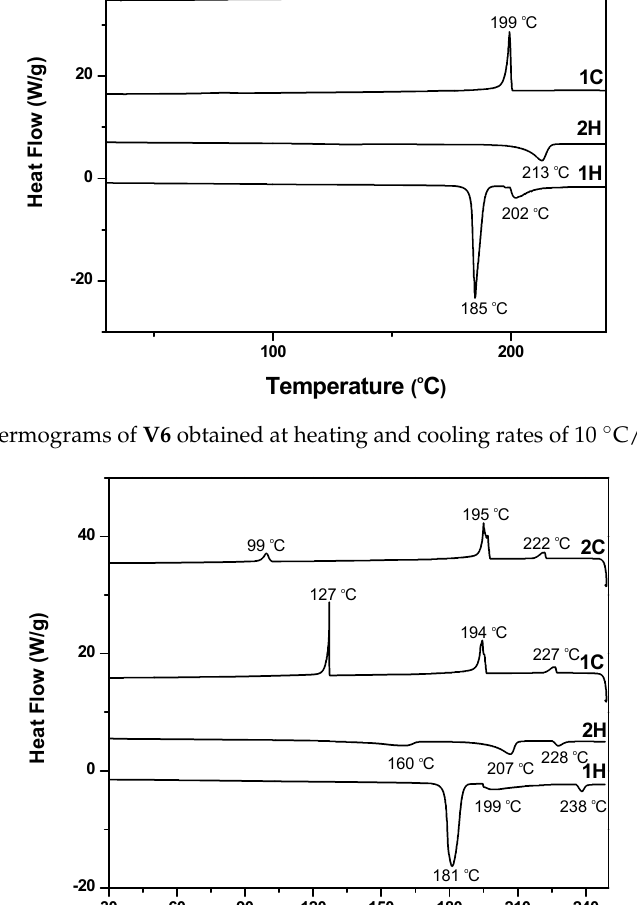
Figure 4. DSC thermograms of V8 obtained at heating and cooling rates of 10 °C/min in nitrogen.